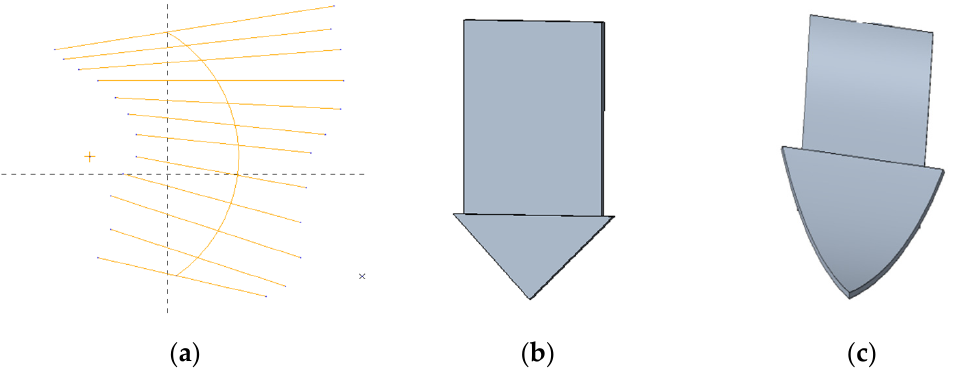
Figure 3. Codonopsis pilosula planting agronomy. ( a ) The plough plots the curve. ( b ) Straight plough. ( c ) The bent plough blade.